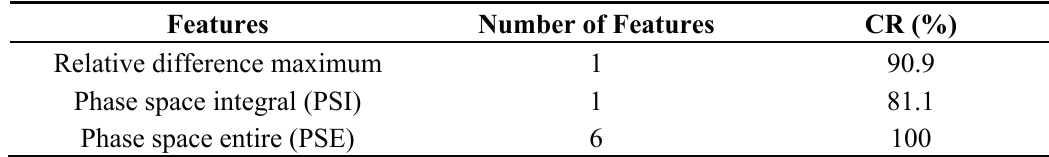
Figure 2. Six parameters extracted from PS. Table 12. Classification rates (CR) of different features in